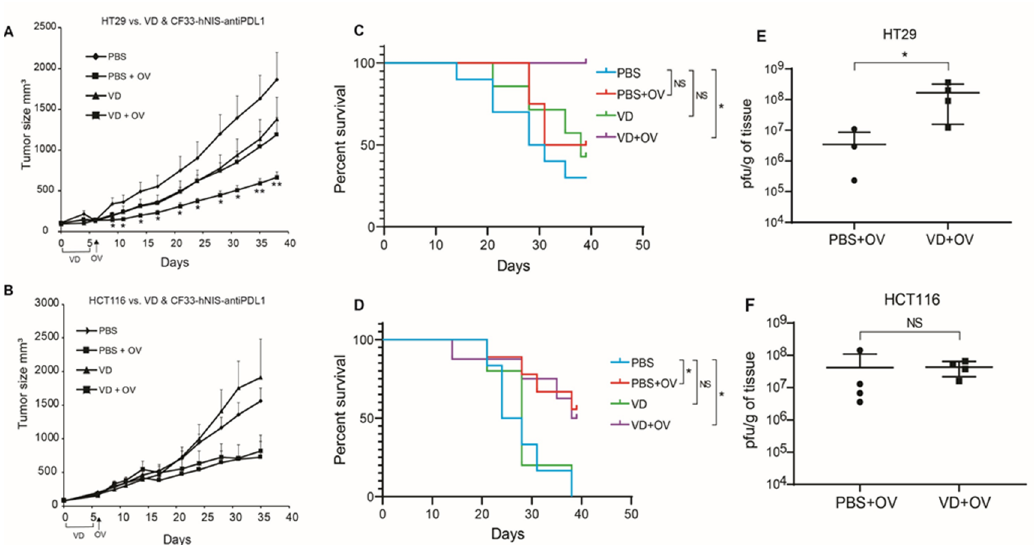
Figure 3. VD analogue (VD) potentiates Oncolytic virus (OV) replication and enhances survival in VD-responsive xenografts. Nude mice bearing flank tumors measuring an average of 160 mm 3 of either VD-responsive HT29 or VD-non-responsive HCT116 were treated with IT PBS alone, IP PBS for 5 days + IT OV (CF33-hNIS-antiPDL1; 1e4 pfu), IP VD alone for 5 days (100 µ g / kg), IP VD alone for 5 days + IT OV (CF33-hNIS-antiPDL1; 1e4 pfu). Tumor volumes are shown for HT29 (PBS n = 10; PBS + OV